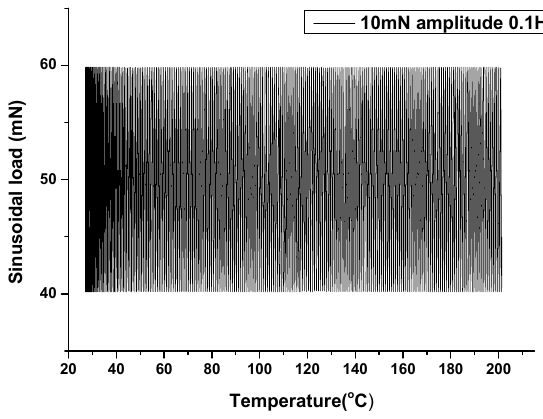
Figure 14. Mechanical load in a tensile mode by DMA.